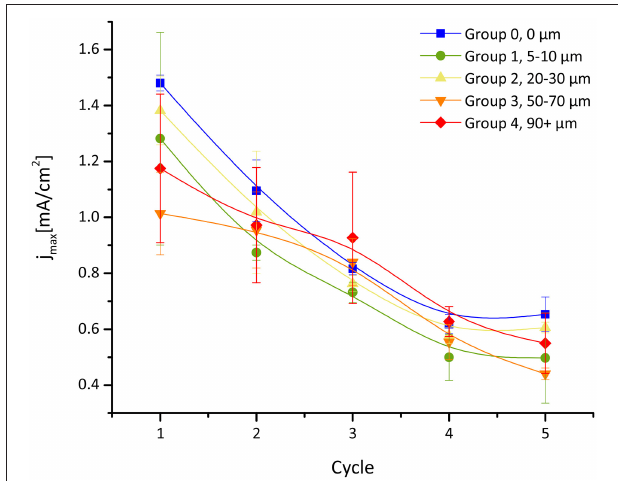
FIGURE 4 | Maximum bioelectrocatalytic current densities over the course of 5 batch cycles (70 days) for different micro-structured Cu electrodes [derived from CA data ( Figure S4